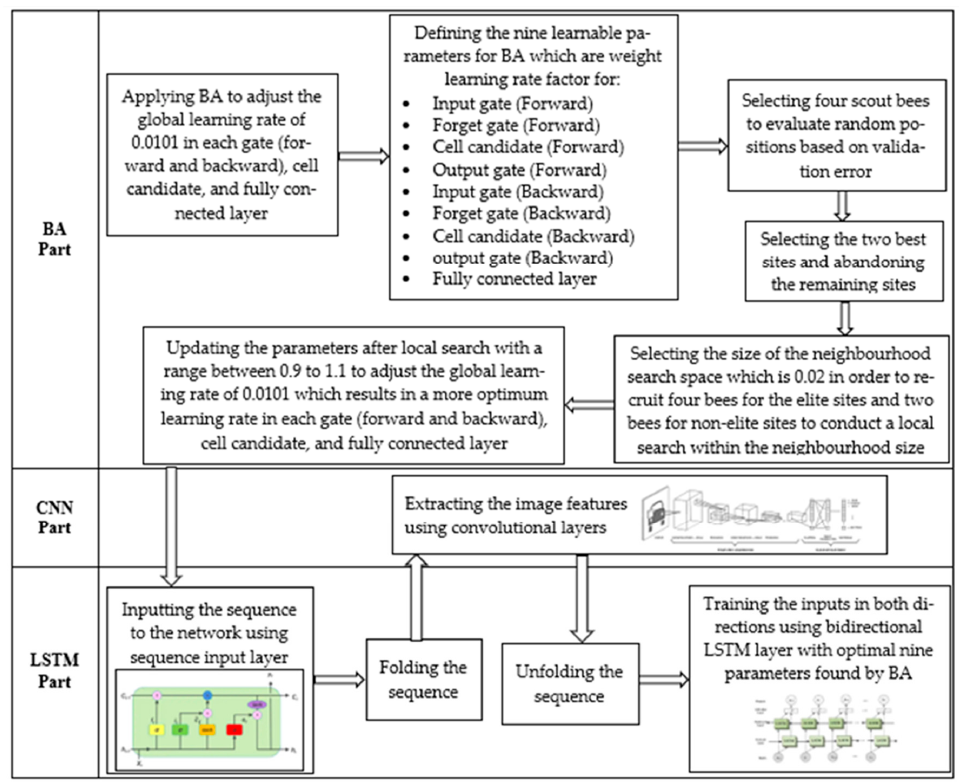
Figure 7. Workflow diagram for the proposed novel hybrid BA-CNN-LSTM algorithm.